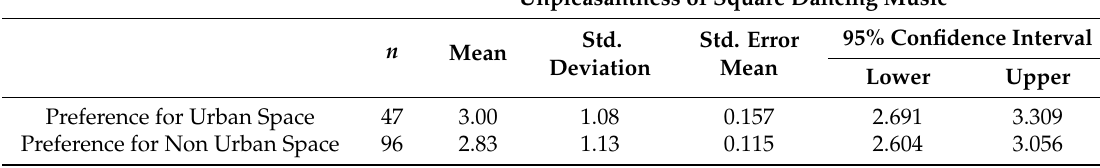
Table 14. Two-Sample T-test with unequal variances comparing unpleasantness of Square Dance Music with preferences for urban or non-urban